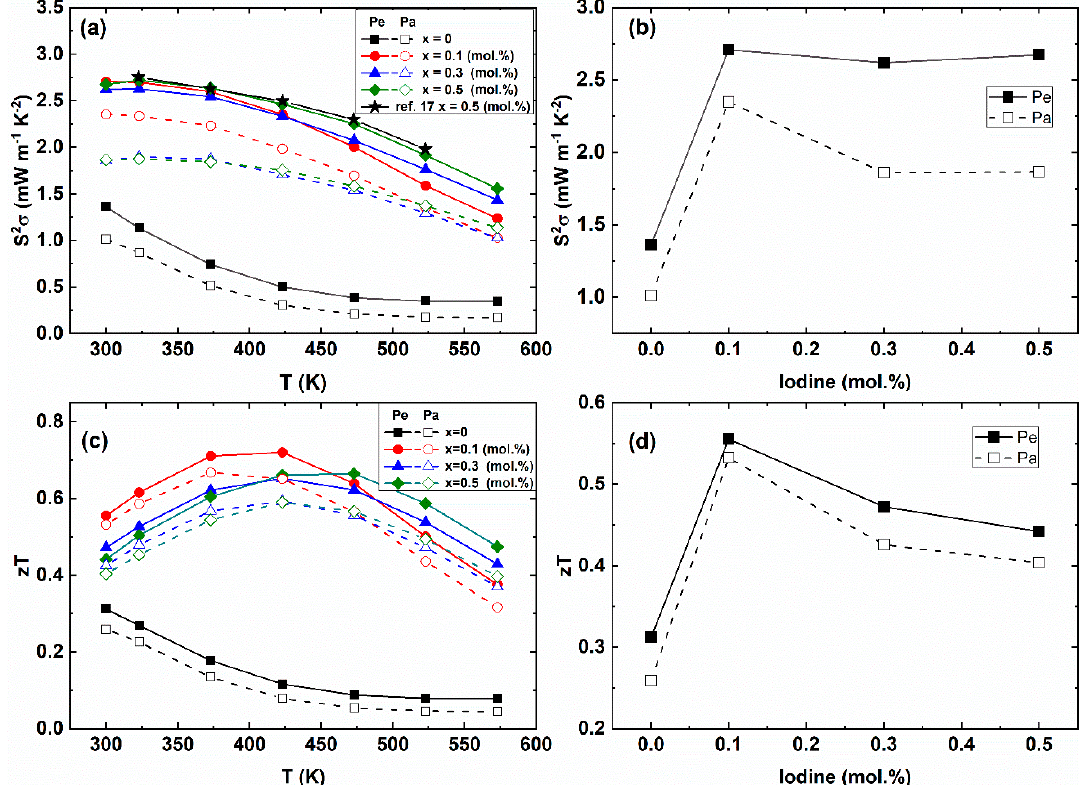
Figure 6. ( a ) Temperature-dependent anisotropic power factor S 2 σ (T) , ( b ) room-temperature power factor as a function of I-doping concentration, ( c ) temperature-dependent anisotropic zT values of the Bi 2 Te 2.85 Se 0.15 I x (x = 0.0, 0.1, 0.3, 0.5 mol.%) compounds ( d ) and the room-temperature zT value with the I-doping concentration.